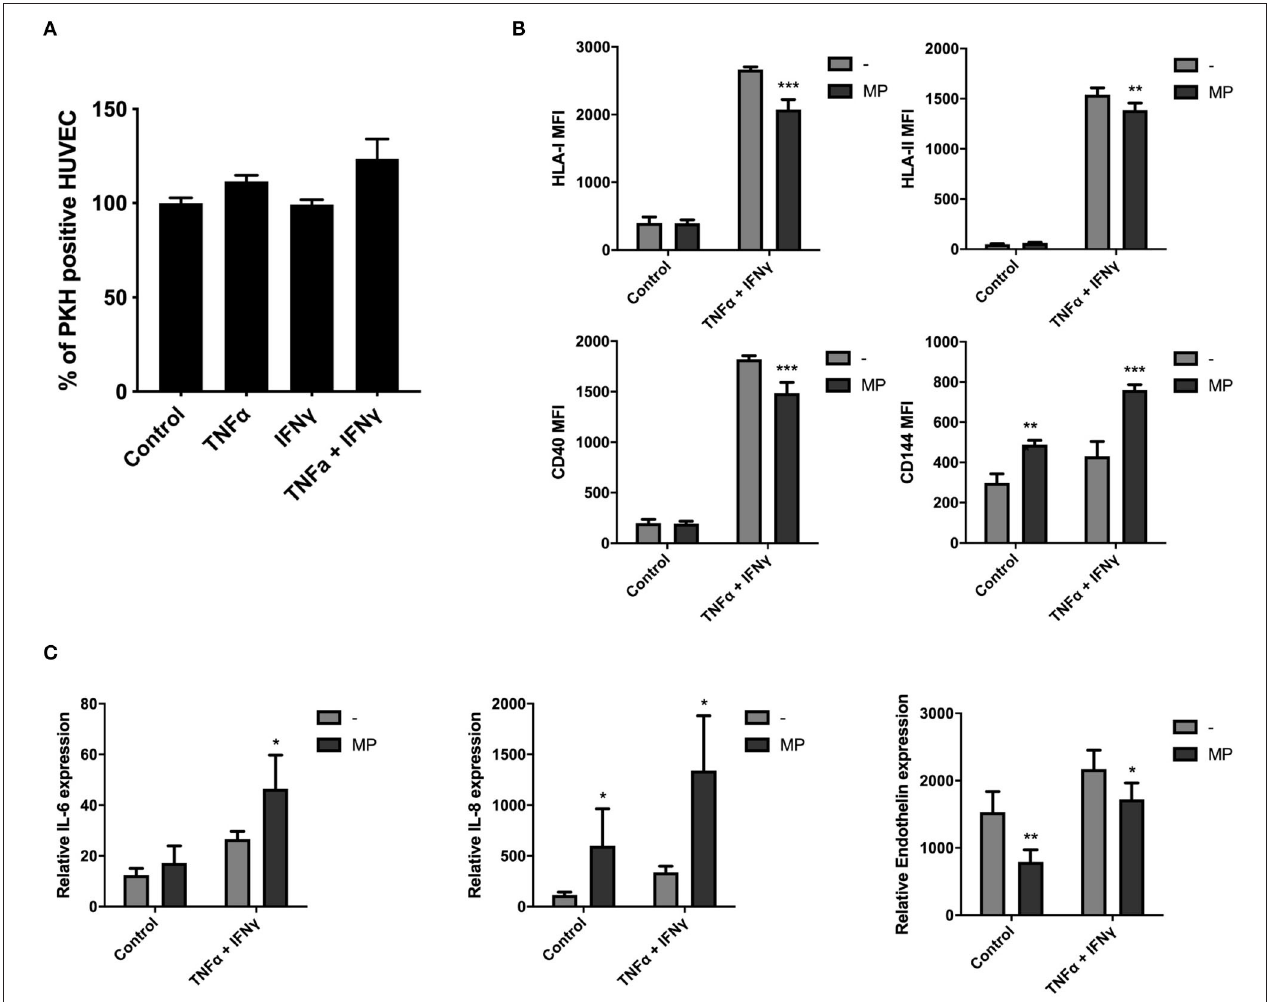
FIGURE 6 | MP uptake modulates HUVEC function under inflammatory conditions. HUVEC were primed with single or combined doses of 10ng/ml TNF α and 50ng/ml IFN γ . PKH-MP were added to the cells (ratio 1:50,000) and incubated for 24h after which uptake was analyzed by flow cytometer. (A) Percentage of HUVEC positive for PKH-MP in different culture conditions. (B,C) HUVEC were separated from MP and assessed by flow cytometer and real-time RT-PCR after 48h. (B) HUVEC surface levels of HLA-I, HLA-II, CD40, and CD144 and (C) mRNA expression of HUVEC for IL-6, IL-8, and endothelin after treated with MP under quiescent or TNF α + IFN γ conditions. Data are presented as mean ± SD from 6 experiments. * P < 0.05 , ** P < 0.01 , and *** P < 0.001 vs. medium control or HUVEC without MP.